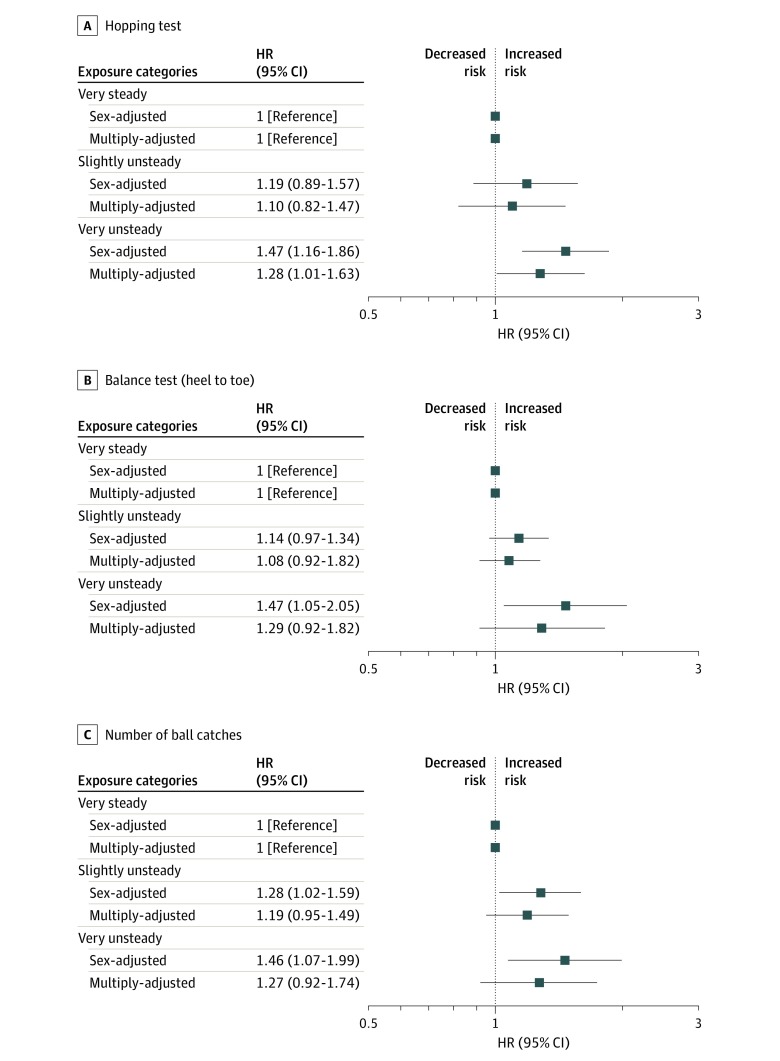
Association of Standing Balance (Foot and Heal-to-Toe) and Ball-Catching Tests at Age 16 years With All-cause Mortality by 58 YearsTests were conducted for standing balance on foot (A), standing balance heel to toe (B), and number of ball catches (C). HR indicates hazard ratio; error bars, 95% CI. Fully adjusted is adjustment for childhood socioeconomic, health, cognitive, and developmental factors as listed in Table 1.